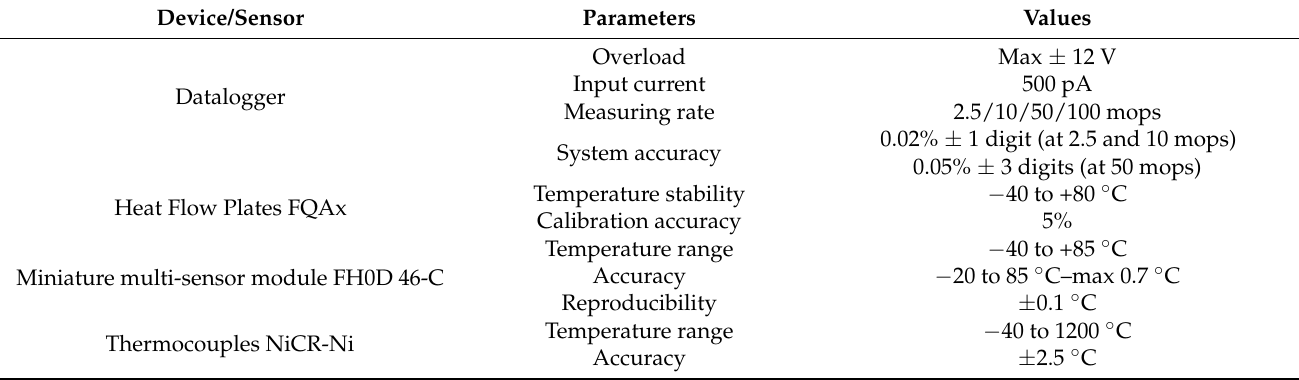
Table 2. Specification of measuring